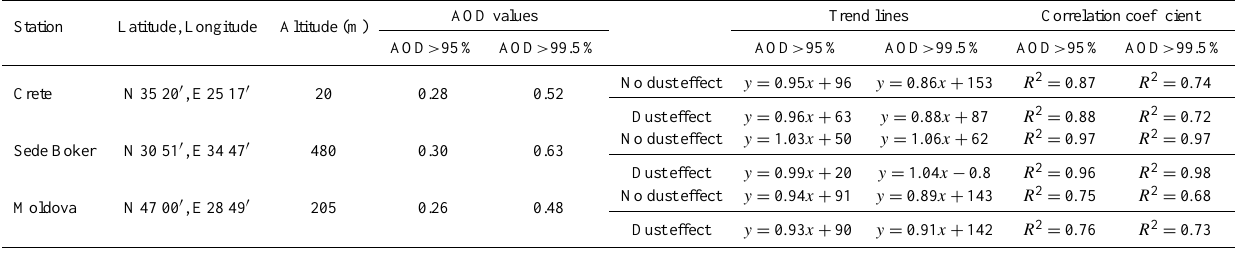
Table 2. Trend lines and correlation coefficients between modeled and measured incoming solar flux at Crete, Sede Boker and Moldova, taking into account days with increased AOD.